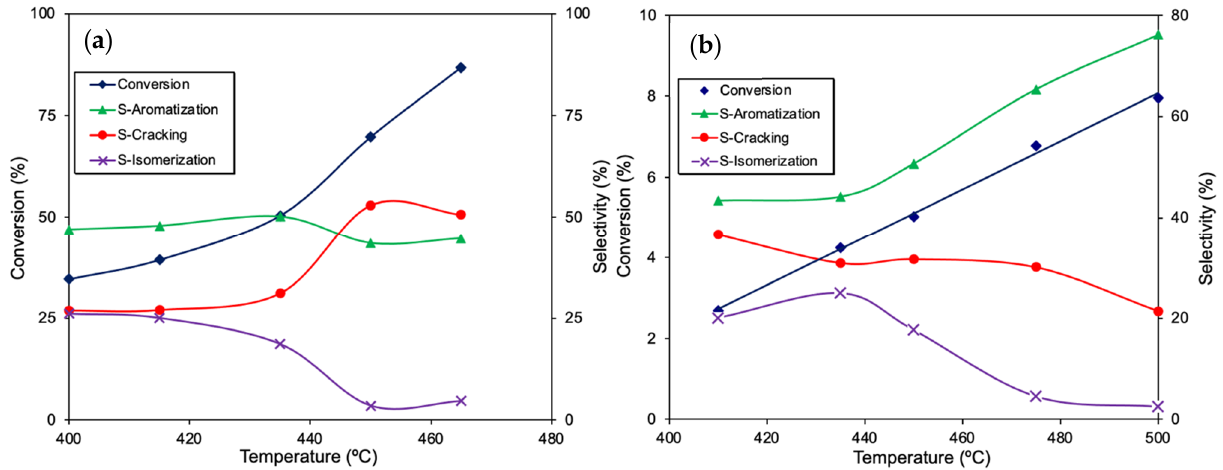
Figure 5. Evolution of conversion and products distribution for sample C900 2Pt as a function of temperature after pretreatment in He at ( a ) 600 °C and ( b ) 900 °C.